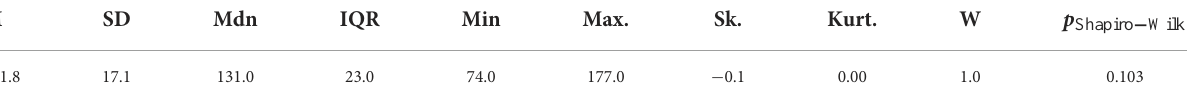
TABLE 3 The descriptive statistics of KAOP scores with the normality test results, N =